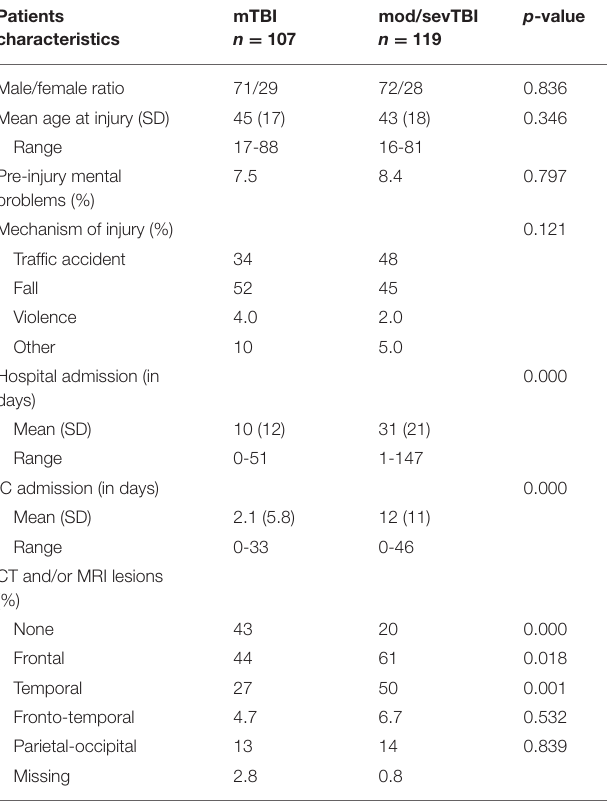
TABLE 3 | Characteristics of behavioral disturbances.